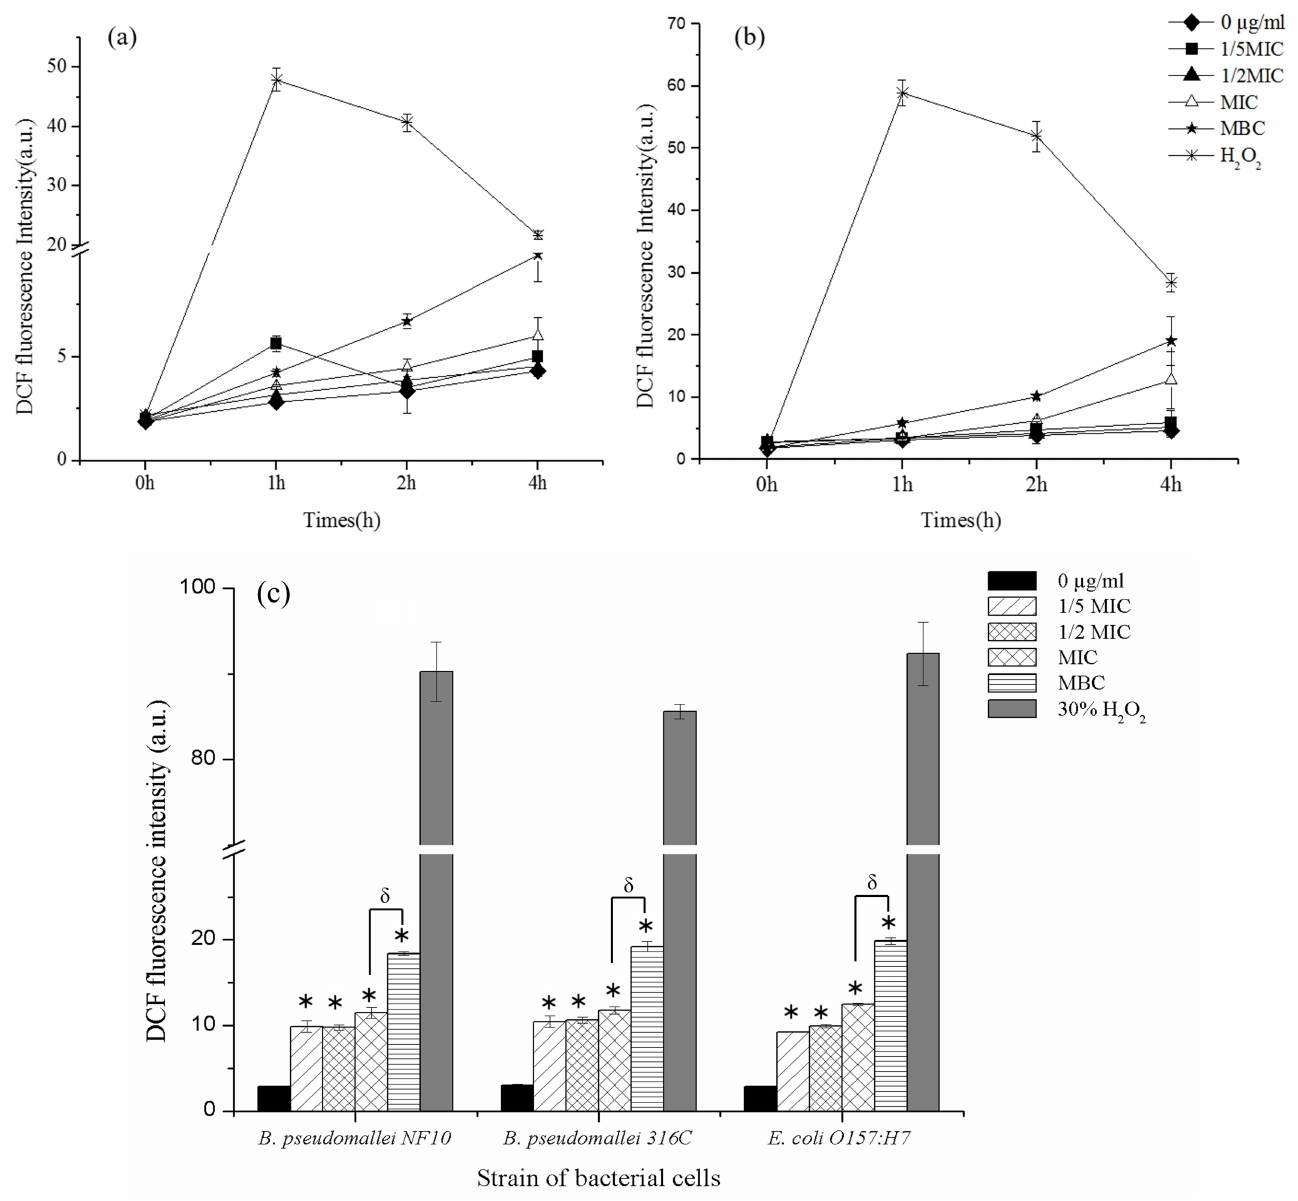
Fig 6. Kinetics of ROS induction in B . pseudomallei after exposure to AgNPs. Kinetics of inductionof ROS in B . pseudomallei NF10 (a) and 316c (b) and accumulatedROS at 4 hrs (c) were followedby DCF fluorescence. All bacterialcells were treated with variousconcentrations of AgNPs: 0 μ g/mL, 1/5 MIC, 1/2 MIC, MIC and MBC of AgNPs. 30% H 2 O 2 was used as a positive control. The overallP-value was determinedusing one-wayANOVA. * indicates a P value of < 0.001in comparisonto bacterial cells treated with deionizewater (0 μ g/mL), δ indicates a P value of < 0.007 in comparisonof MIC with MBC treated condition.Data representthe means standard errors of the means for triplicate samples. Results shown are representative of two